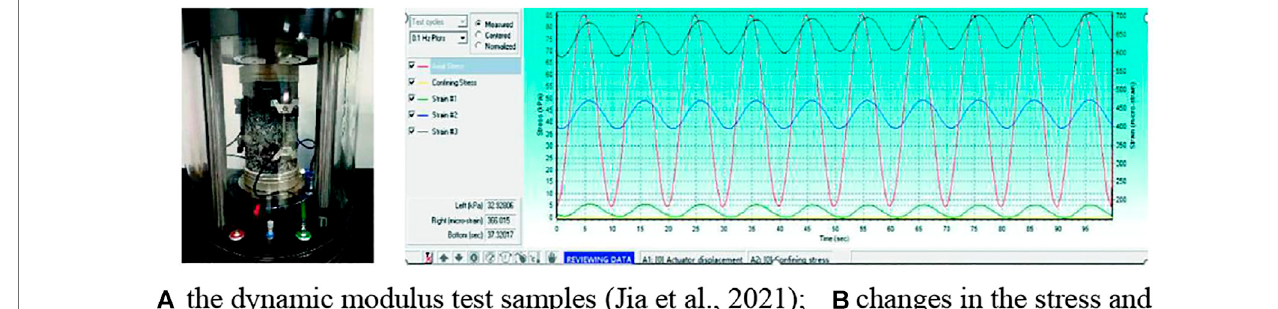
Frontiers in Materials |